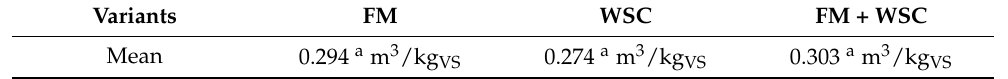
Legend to Table 8: Different small letters illustrate demonstrable differences between the respective experimental treatments at a level of significance p < 0.05. FM—fodder mallow, WSC—white sweet